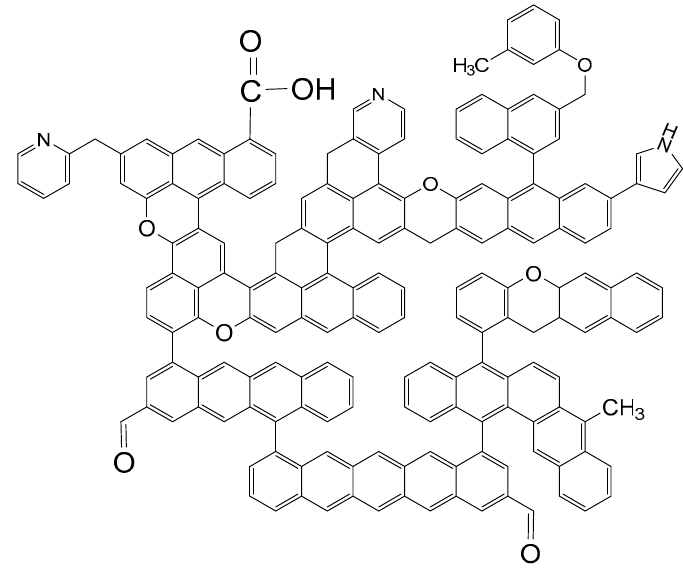
Figure 5. Molecular structure model of gas coal.